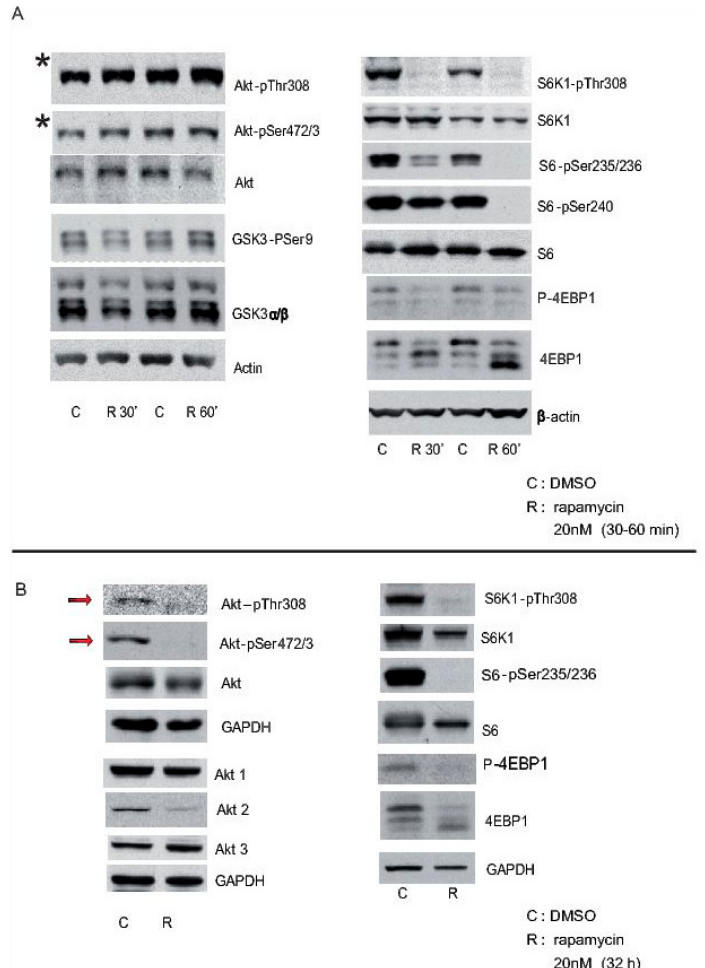
Figure 1. Effects of pharmacological inhibition of mTORC1 on cultured primary cortical neurons. The status of the Akt-mTORC1 pathway was analysed after 30 min or 60 min of rapamycin